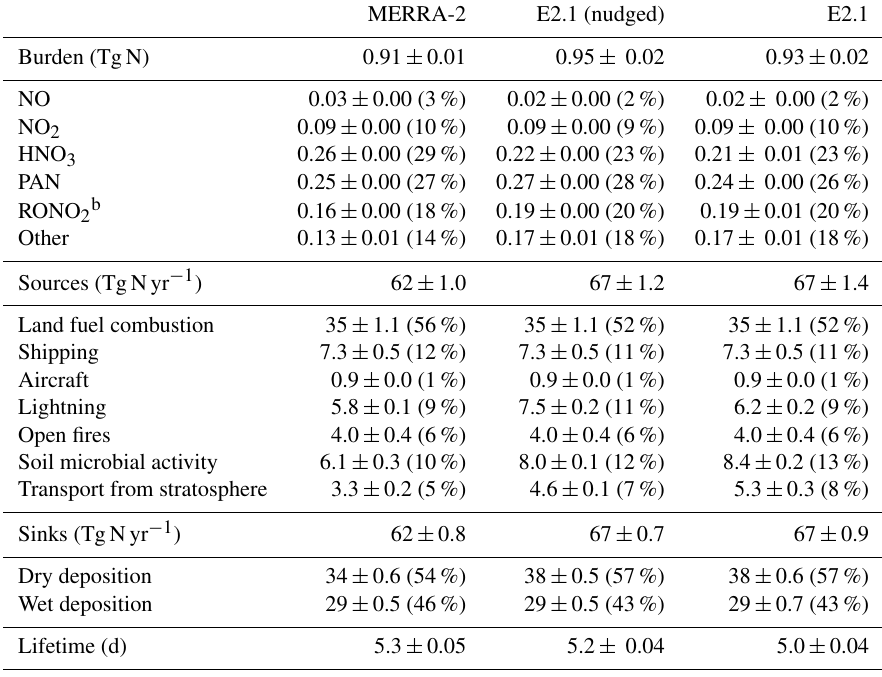
Table 6. Tropospheric total reactive nitrogen (NO y ) a family budget for